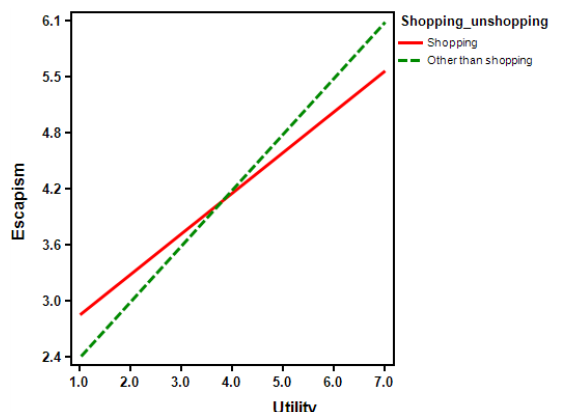
Figure 6. Utility-escapism interaction Figure 7. Escapism-RPI